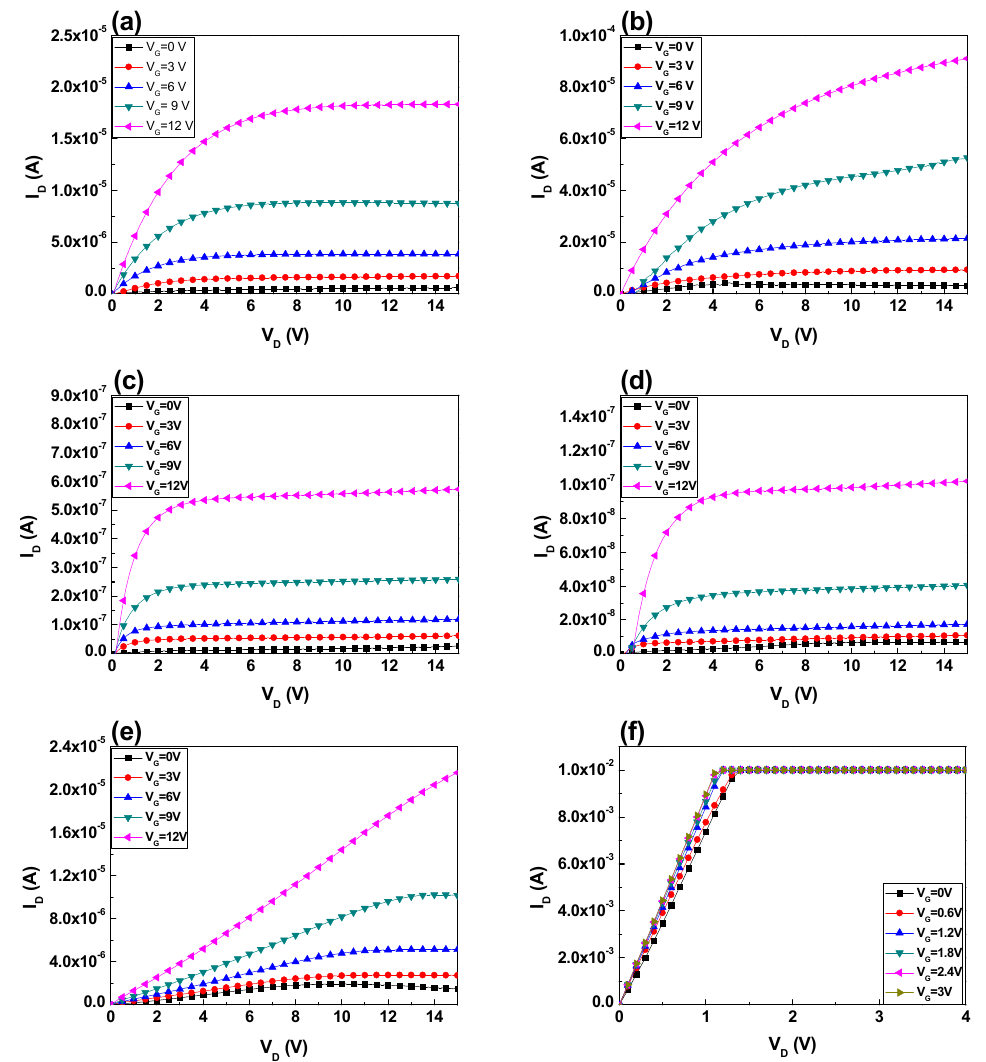
Figure 4. I D - V D of InTiZnO TFTs as a function of oxygen flow ratios: ( a ) Sample A, ( b ) Sample B, ( c ) Sample C, ( d ) Sample D, and ( e ) Sample E, and ( f ) Sample F with 0% oxygen flow ratio.